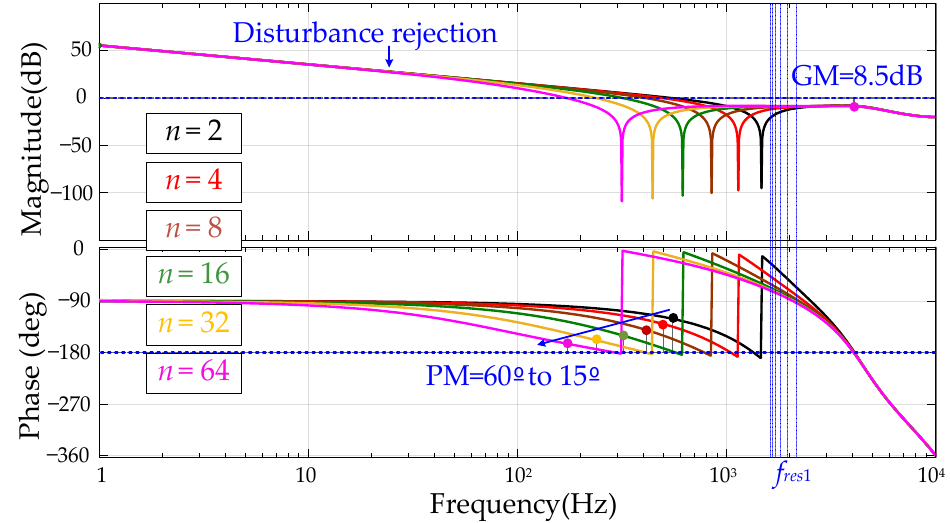
Figure 6. Frequency response of the common current under n = 2, 4, 8, 16, 32 and 64 with the proposed control scheme.